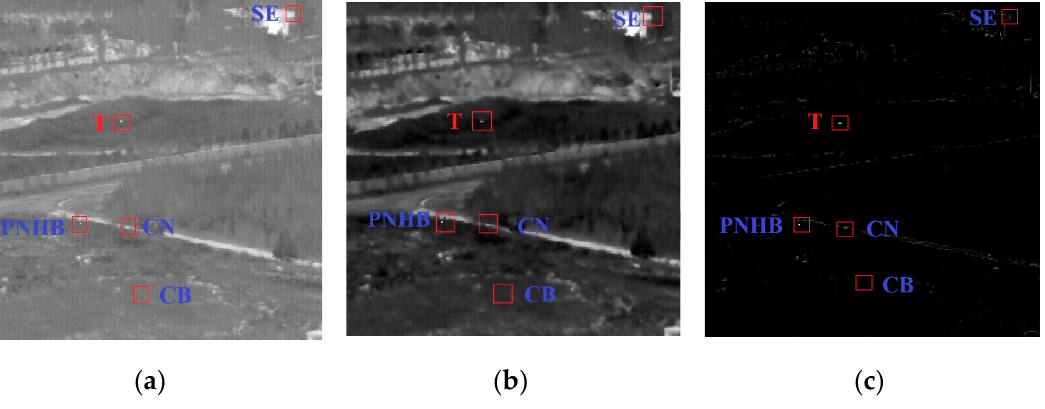
Figure 2. Preprocessing stage map. ( a ) Original IR image. ( b ) Image after being smoothed and denoised. ( c ) High-pass filtering image.